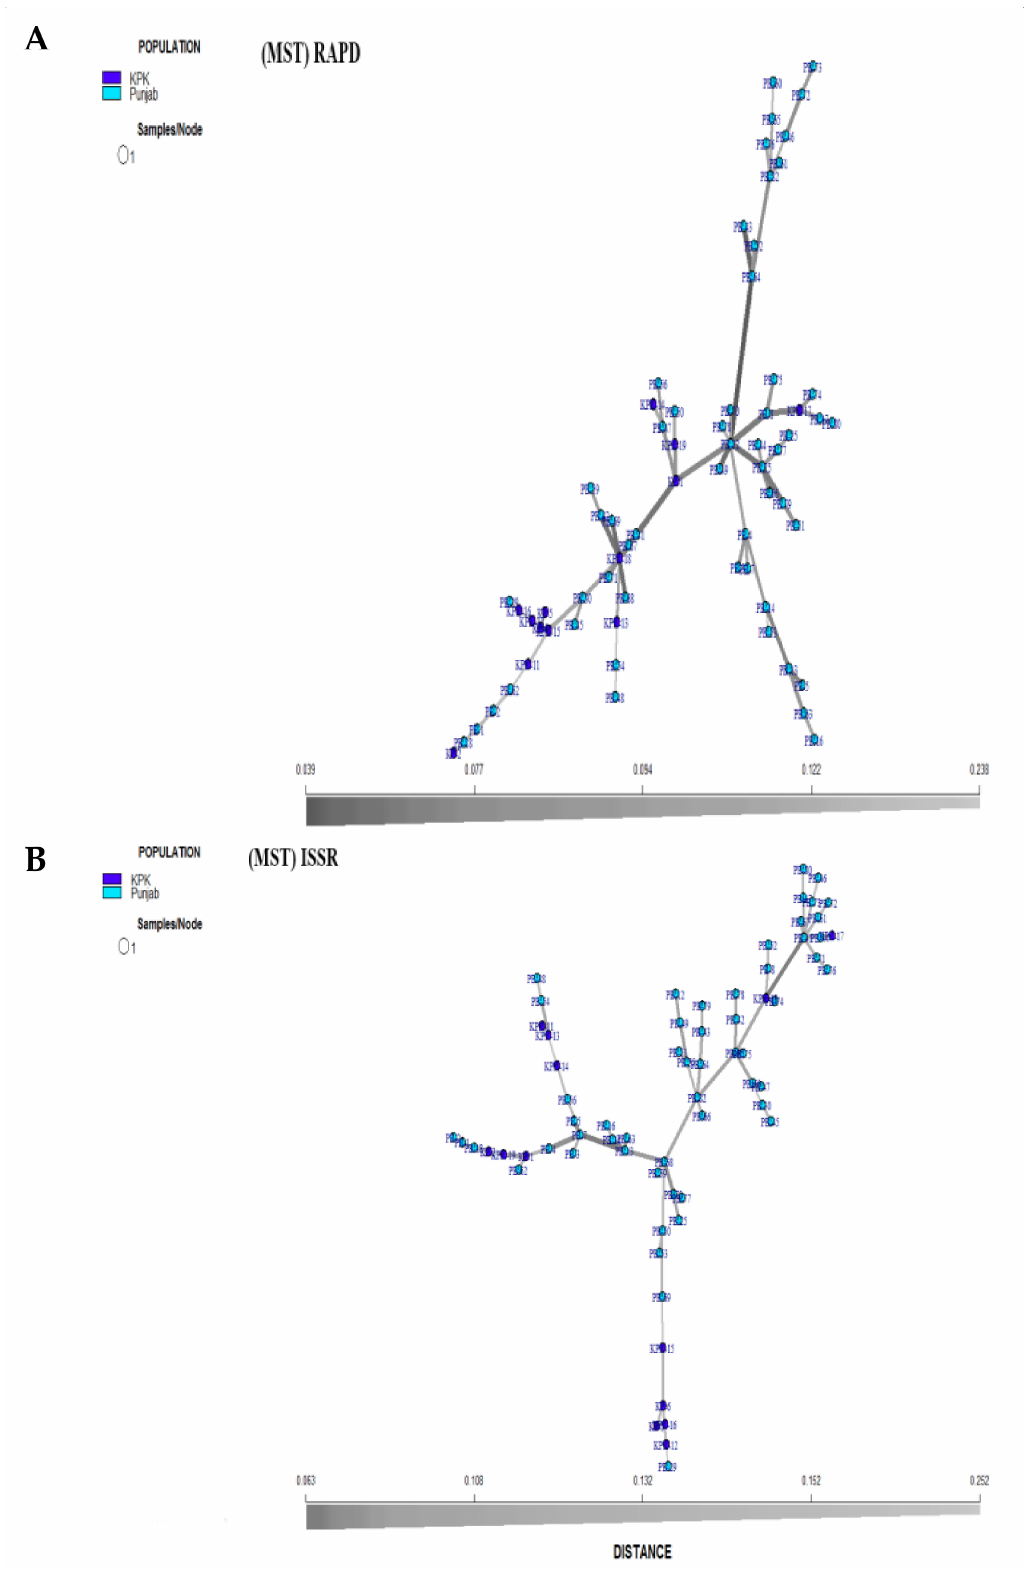
Figure 6. Minimum Spanning Tree (MST) analysis using Bruvo’s distance illustrating the relationships and the relative frequency of each isolates. Circle colors represent the population of T. indica isolates based on ( A ) RAPD, ( B )